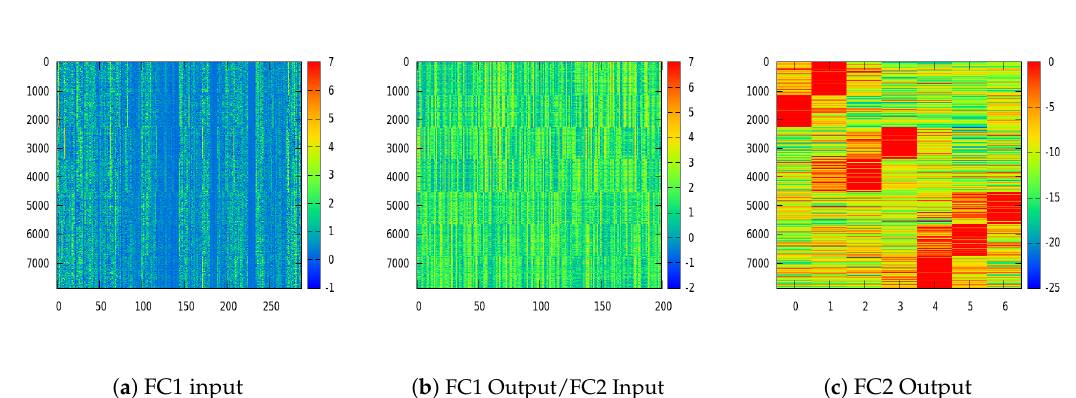
Figure 8. Extracted features from different layers in the proposed “Model 2” network with ordered 8000 sample training images and 7 navigation choices (X-axis: feature dimension; Y-axis: index of samples, best viewed in color). The network nonlinear mappings of fully connected layer 1 (FC1) (( a ) → ( b )) and FC2 (( b ) → ( c )) enhance the discriminability one after another.